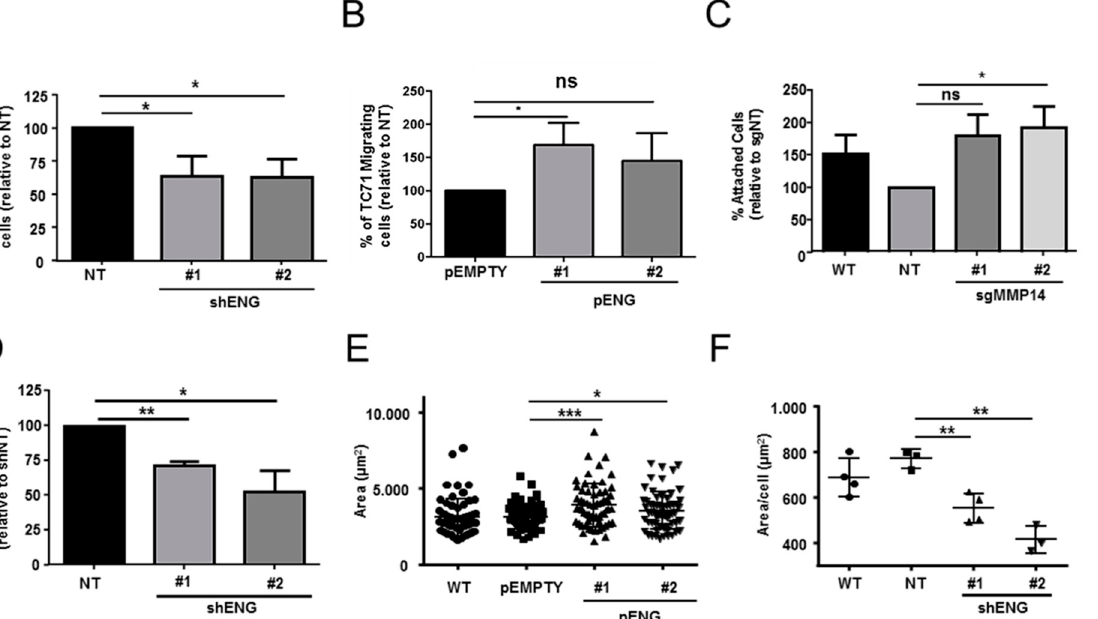
Figure 4. Cell migration and adhesion are positively regulated by ENG in association with actin filaments and filopodia formation in ES cells in vitro. ( A ) Cell migration assay of RM82 shENG cells in Boyden chamber. In the absence of ENG, migration was significantly reduced in comparison to the control condition. ( B ) Cell migration assay from TC71 pENG cells in Boyden chamber. Overex- pression of ENG promoted migration, which was statistically significant in one of the clones. ( C ) Cell–substrate attachment assay using RM82 sgMMP14 cells on 20 µg/mL FN for 15 min. Expression of MMP14 significantly impaired attachment on FN. ( D ) Cell attachment assay from the RM82